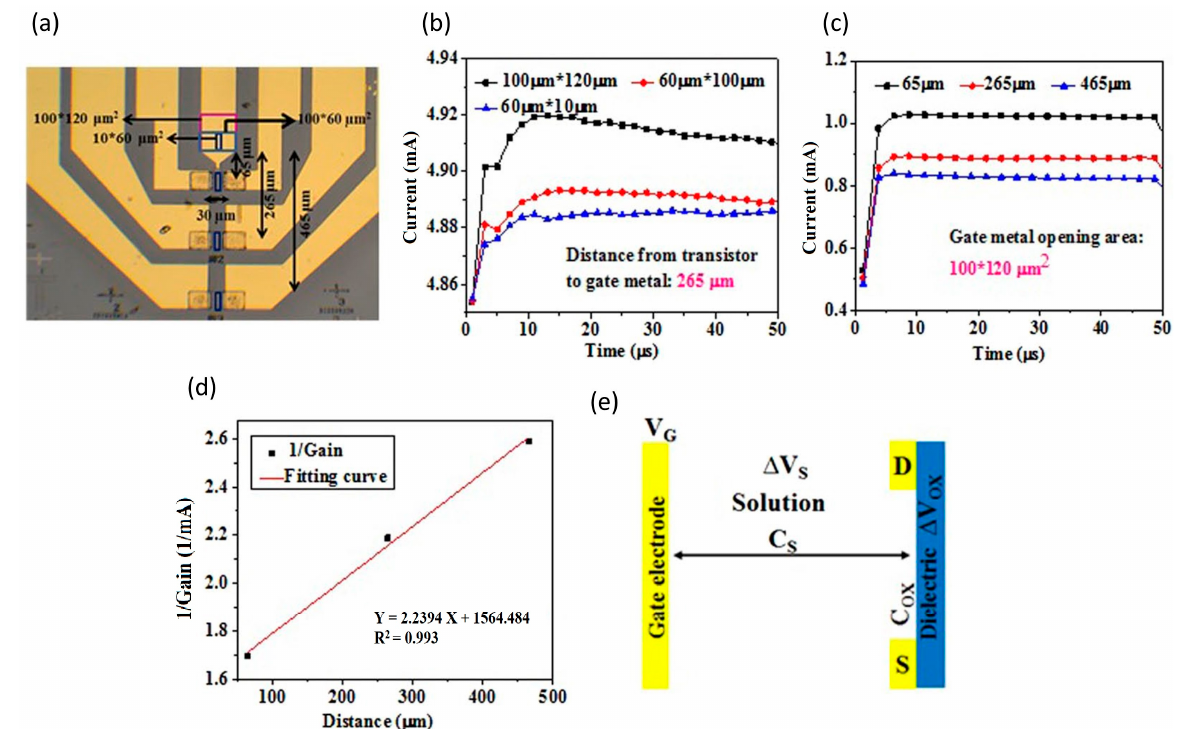
Figure 9. ( a ) EDL HEMT top view with several geometries created. Changes in drain current with comparison of ( b ) a different gate electrode opening regions and ( c ) and different gap geometries between gate opening and active channel. ( d ) Output gain current with increasing gap distance. ( e ) Schematic diagram of voltage drops across EDL HEMT. Reproduced with permission from reference [147]. Copyright 2017 Nature.